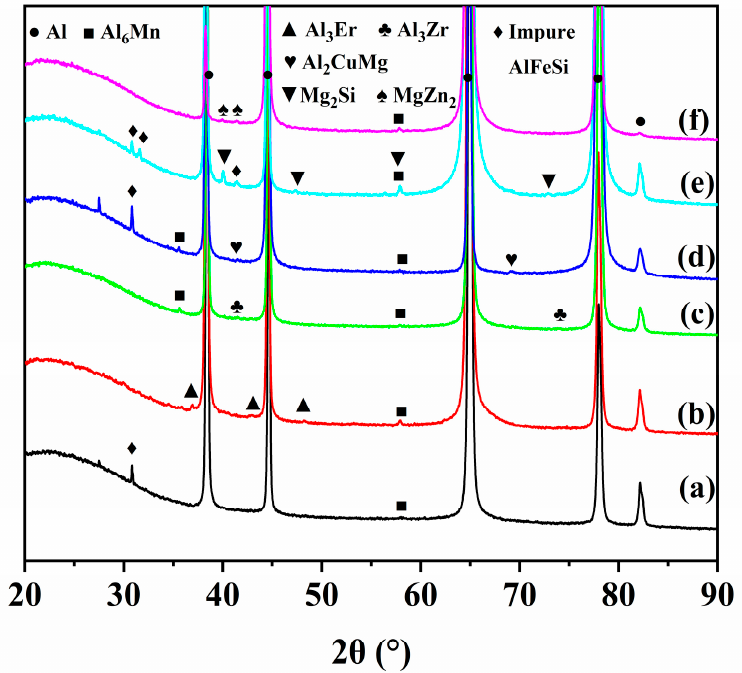
Figure 7. X-ray diffraction patterns of cold rolled alloys: ( a ) Al-3Mg-0.5Mn; ( b ) Al-3Mg-0.5Mn-0.2Er; ( c ) Al-3Mg-0.5Mn-0.2Zr; ( d ) Al-3Mg-0.5Mn-0.2Cu; ( e ) Al-3Mg-0.5Mn-0.2Si; ( f ) Al-3Mg-0.5Mn-0.2Zn.